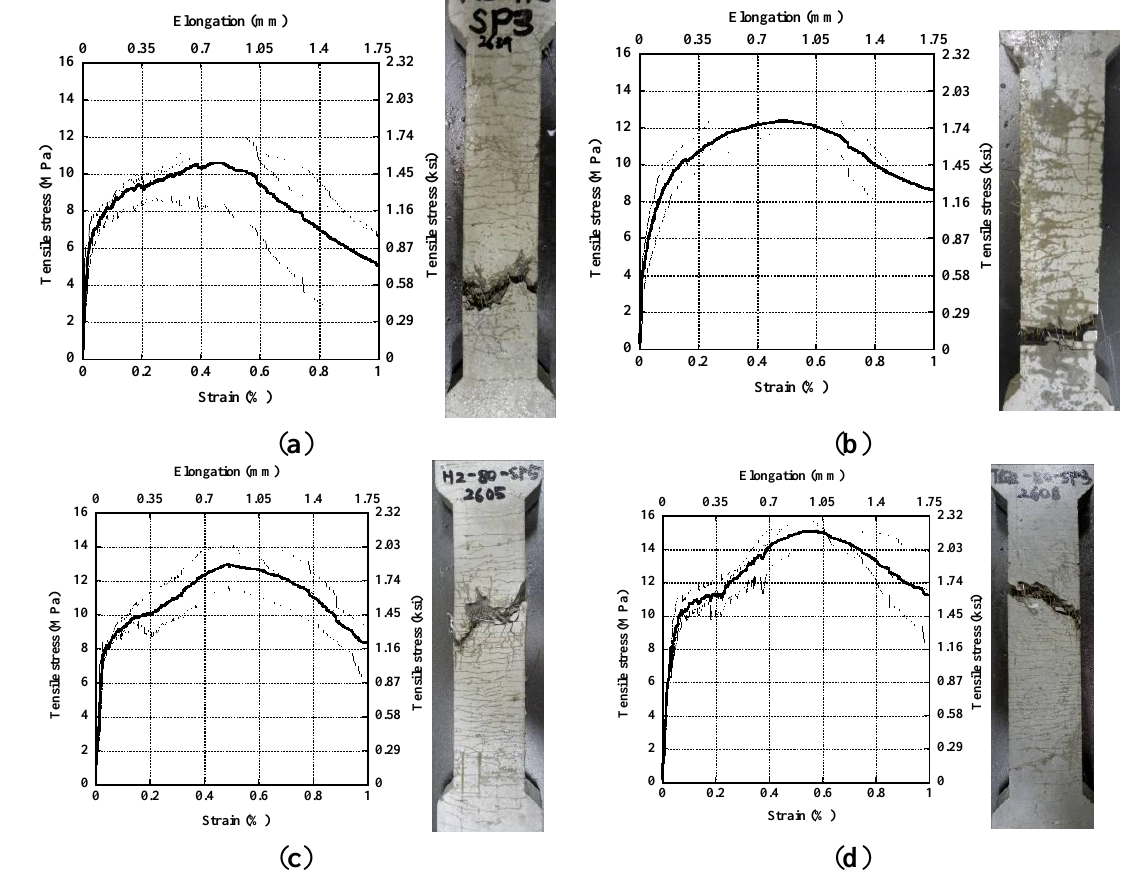
Figure 8. Tensile stress–strain curve of HPSFRCs according to types of fiber and sand. ( a ) H-fiber 2% in matrix A; ( b ) T-fiber 2% in matrix A; ( c ) H-fiber 2% in matrix B; ( d ) T-fiber 2% in matrix B.